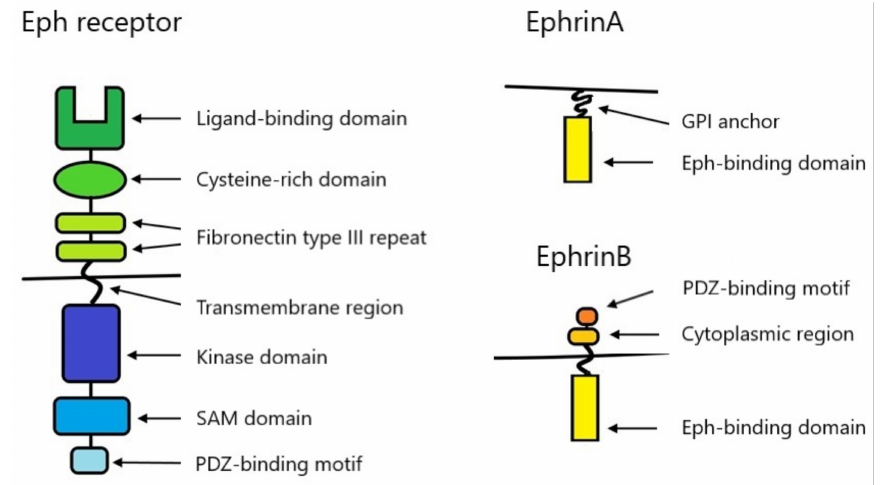
Figure 1. Structure of Eph and